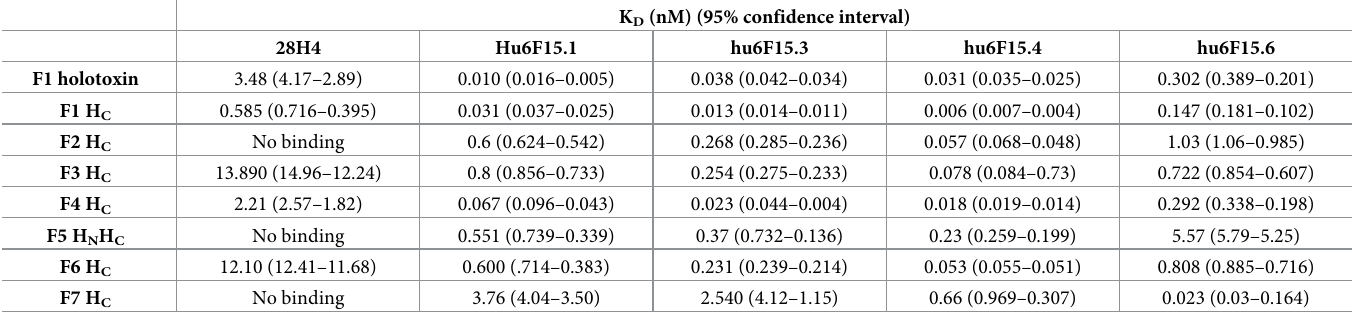
Table 2. K D values of IgGs for F toxin domains as measured with KinExA